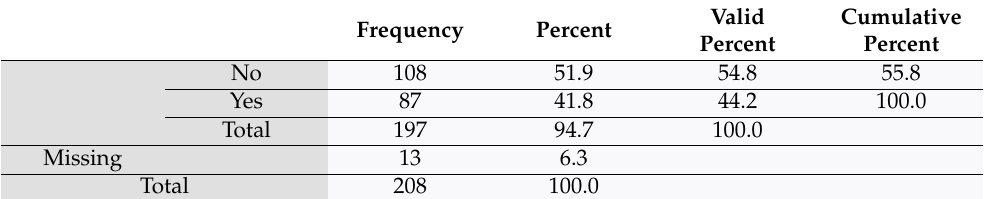
Table 7. Do you suffer from orofacial/TMJ pain?